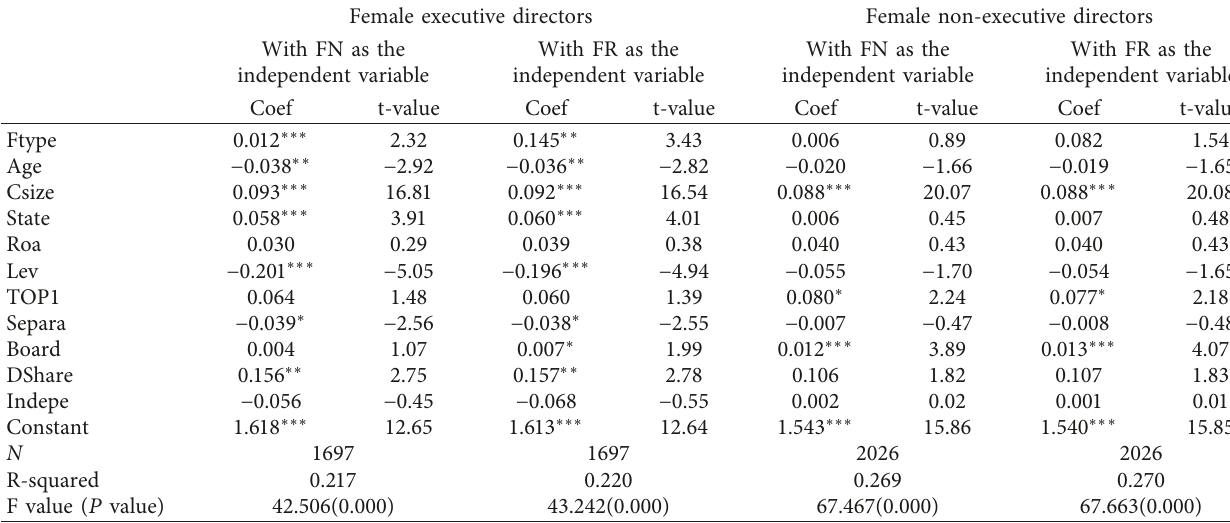
Table 7: Regression results of different types of FDs on